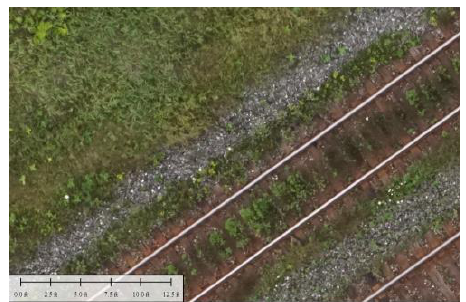
Figure 9: Sample zoomed in orthophoto displayed in Global